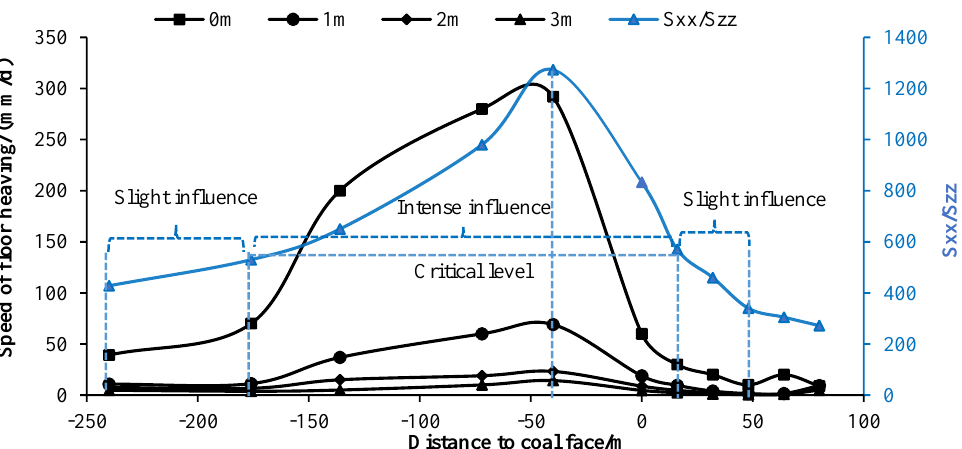
Figure 10. Heaves at different depth of the floor strata.